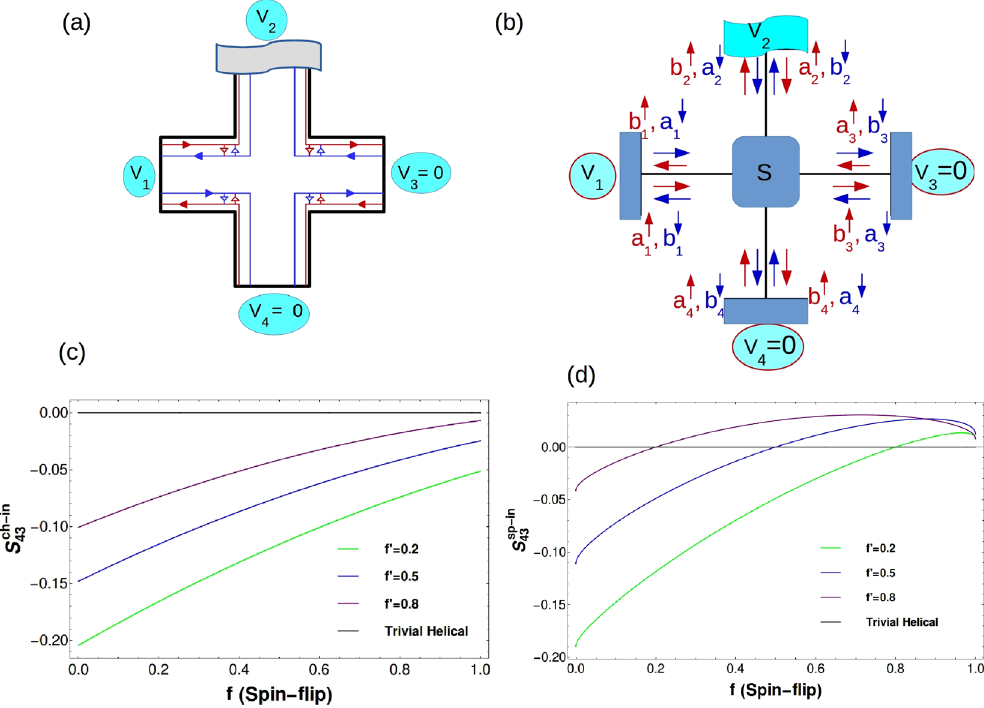
Figure 10. The set-ups to distinguish the spin-momentum locked trivial quasi-helical phase ( a ) from the trivial ballistic phase ( b ) are designed such that there are no disordered probes. Scattering happens only inside samples. The effect of spin-flip ( f ) and back-scattering ( f ′ ) on the non-local charge ( c ) and spin correlations ( d ). The trivial quasi-helical phase yields zero charge and spin correlations while trivial ballistic phase yields negative charge correlations and positive spin correlations. ( a ) The trivial quasi-helical phase: spin-momentum locked edge modes are only susceptible to spin-flip scattering. ( b ) The trivial ballistic phase: ballistic modes are susceptible to both spin-flip as well as backscattering. ( c ) Non-local charge correlations. ( d ) Non-local spin